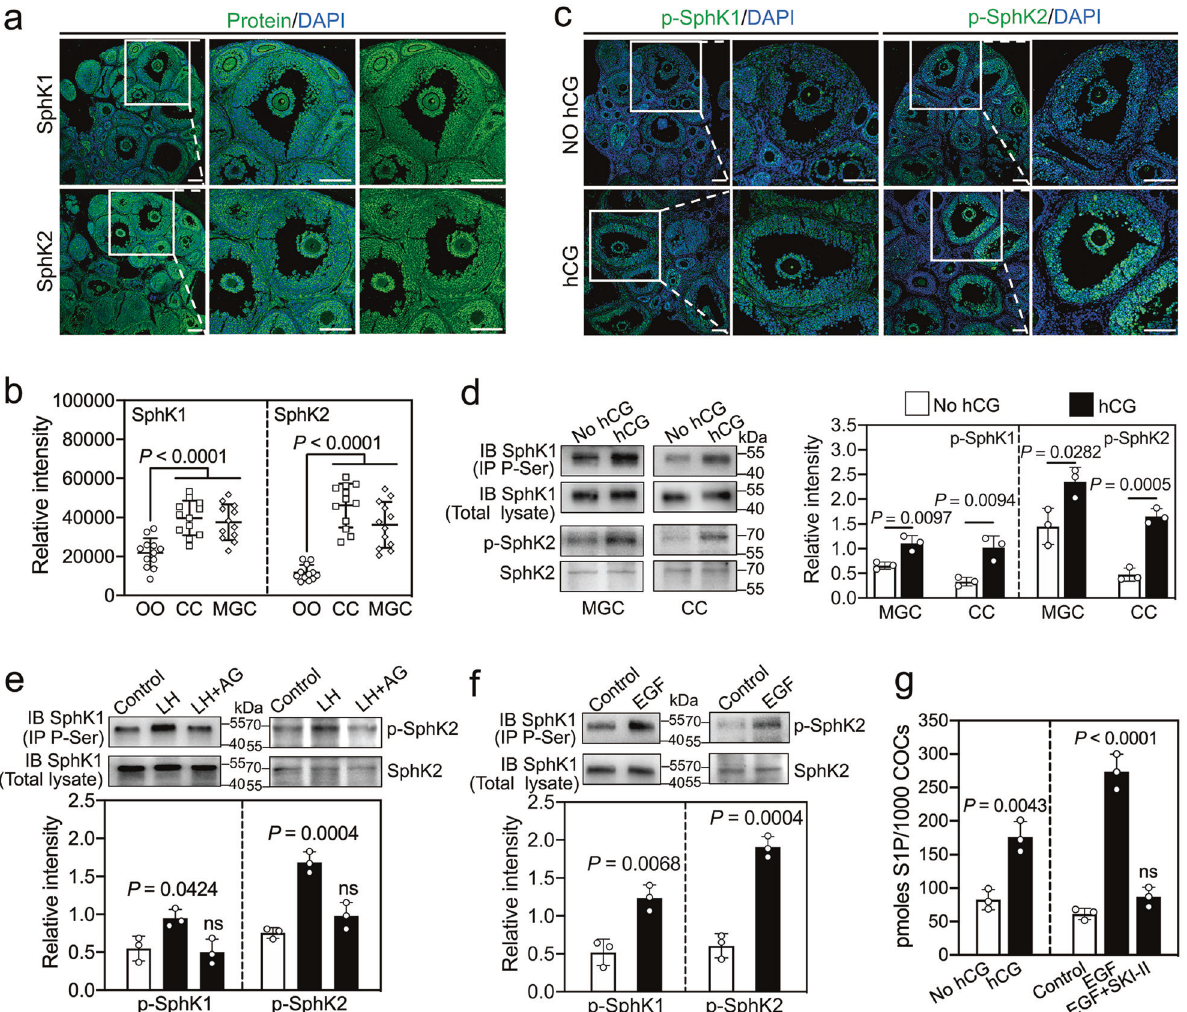
Fig. 1 LH/hCG and EGF increases phosphorylated SphK and S1P levels. a Representative images of SphK1 and SphK2 (green) staining in ovaries isolated from eCG-primed mice. The nuclei were counterstained with DAPI (blue). The enlarged views of the boxed area are shown on the right side. b Fluorescence intensity analysis of SphK1 and SphK2 in oocytes (OO), cumulus cells (CC), and MGCs. A total of 12 large antral follicles were scored. c Representative images of p-SphK1 and p-SphK2 (green) staining in ovaries isolated from the mice before (no hCG group) and after hCG treatment (2 h). The nuclei were counterstained with DAPI (blue). The enlarged views of the boxed area are shown on the right side. d – f Western blotting analysis of p-SphK1 and p-SphK2 levels in MGCs and/or cumulus cells isolated from the mice before and after hCG treatment (2 h, d ), the follicles at 2 h of culture ( e ) and the COCs at 2 h of culture ( f ). For p-SphK1, cell lysates were immunoprecipitated with anti-P-Ser antibodies and immunoblotted for SphK1. SphK1 in total lysates was used as an internal control. For p- SphK2, total SphK2 was used as an internal control. g The effects of hCG and EGF on the S1P levels of COCs. The concentration of SKI-II was 20 μ M. For a – g , n = 3 independent experiments. The data represent the mean ± s.d. P values were determined by two-sided Student ’ s t -test ( d , f , left panel of g ) and one-way ANOVA followed by Tukey ’ s test ( b , e , right panel of g ). ns, not signi fi cant. Scale bars, 100 μ